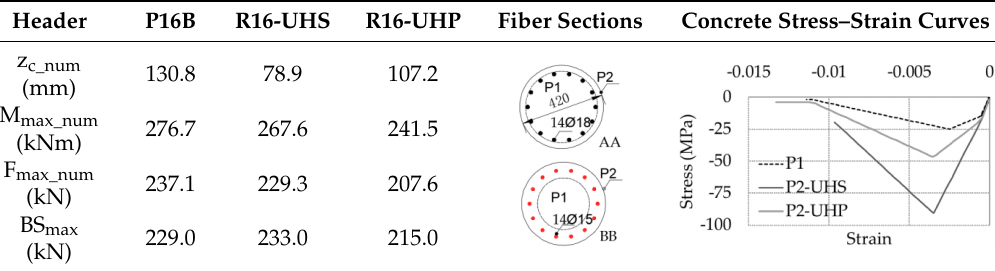
Table 7. Numerical fiber section analyses by OpenSees [46]: height of the section compression